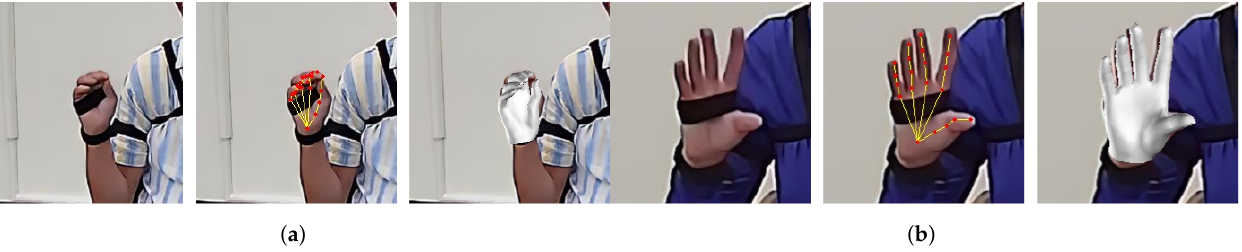
Figure 9. Qualititive results on PD-APDM-Hand dataset: ( a ) PD subject 1; ( b ) PD subject